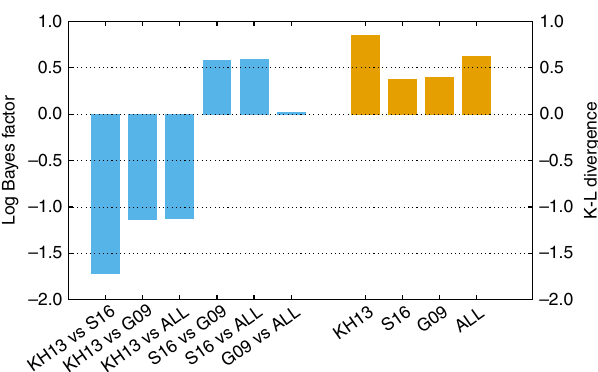
Fig. 2 Bayes factors and Kullback – Leibler divergences for different models. We compare the Bayes factors between model pairs (left hand, blue bars) and the Kullback – Leibler (K-L) divergences between the prior and posterior of the characteristic amplitude (right hand, orange bars). The small range of Bayes factors indicates that there is little to choose from between these models, although KH13 is weakly disfavoured against the others. The K-L divergences also support this conclusion. Although all values are small, KH13 has the largest K-L divergence (greatest difference between prior and posterior) of the four